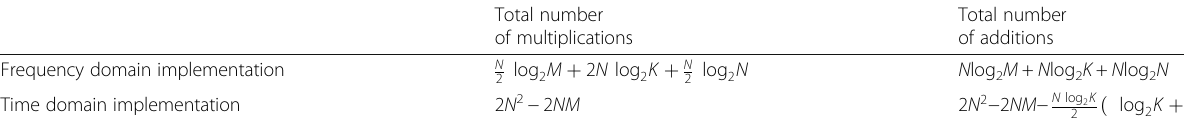
Table 1 Computational complexity of optimum tree-structured analysis/synthesis filter bank